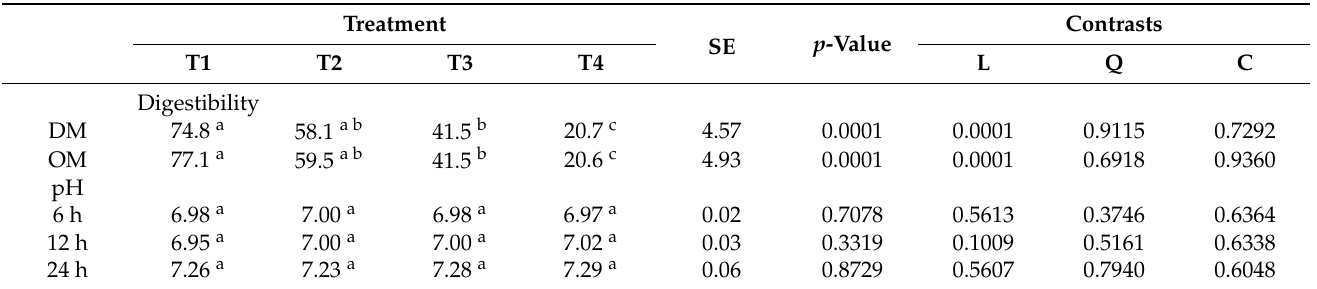
Table 3. In vitro digestibility (DM and OM) of diets with increasing levels of A. mearnsii (%, except where otherwise noted) and pH.